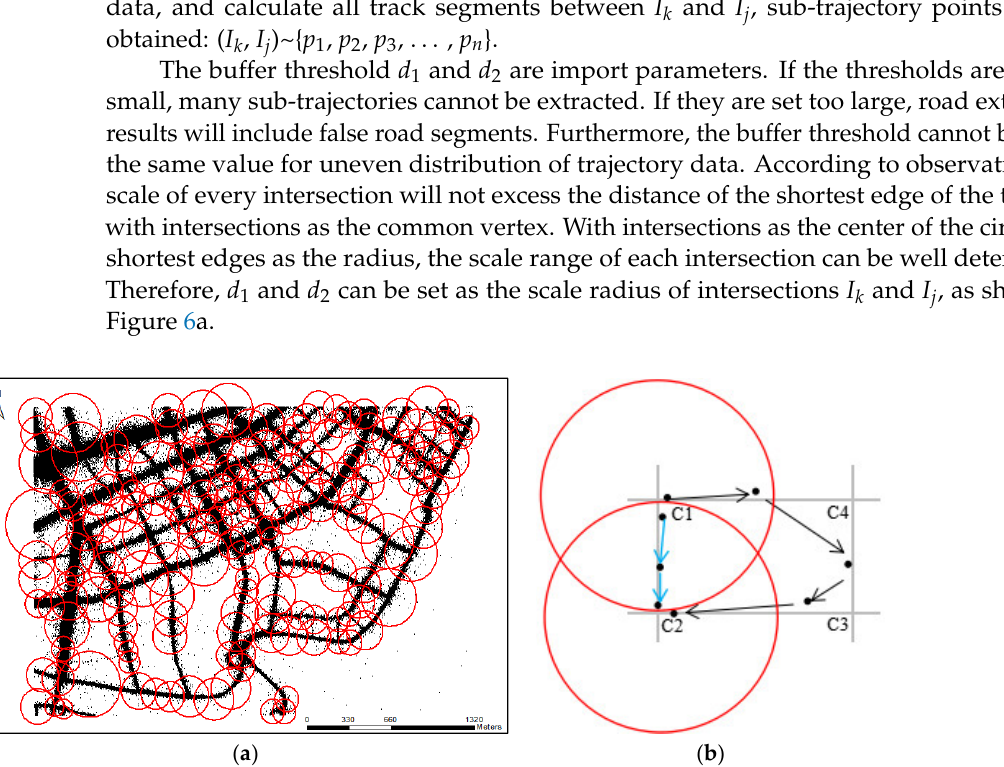
Figure 6. Sub-trajectory extraction. ( a ) Intersection scale estimation; ( b ) Sub-trajectory limitation.